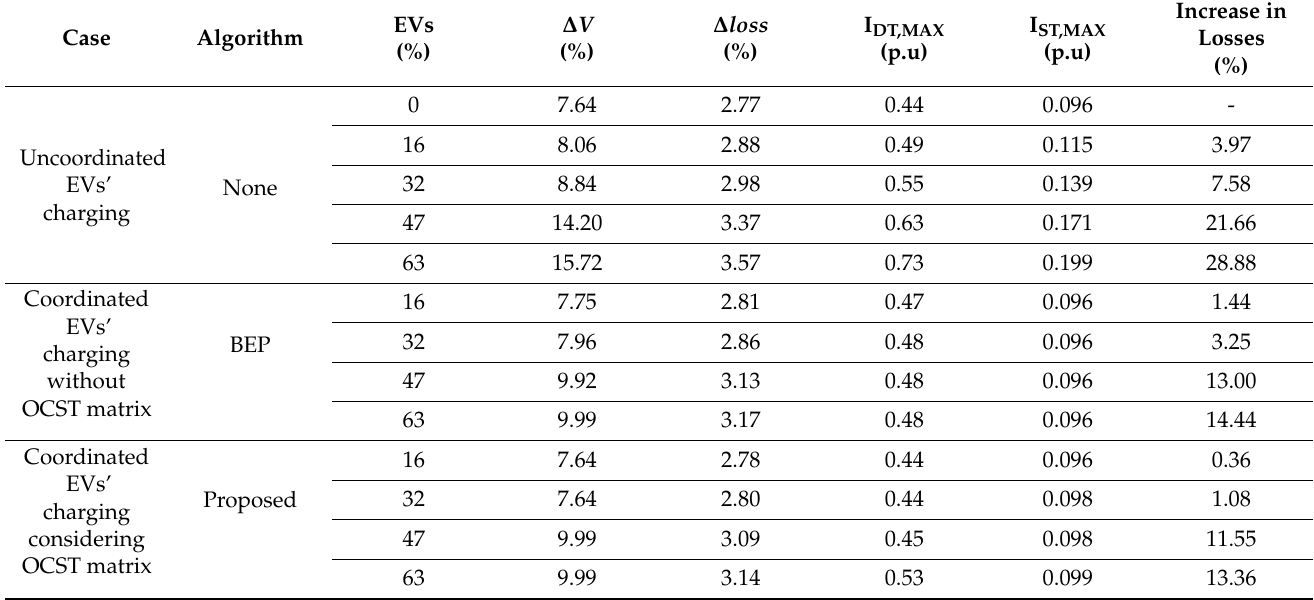
Figure 8. Impact of random uncoordinated EVs’ charging on system power loss. Table 1. A comprehensive comparison of results of all the three